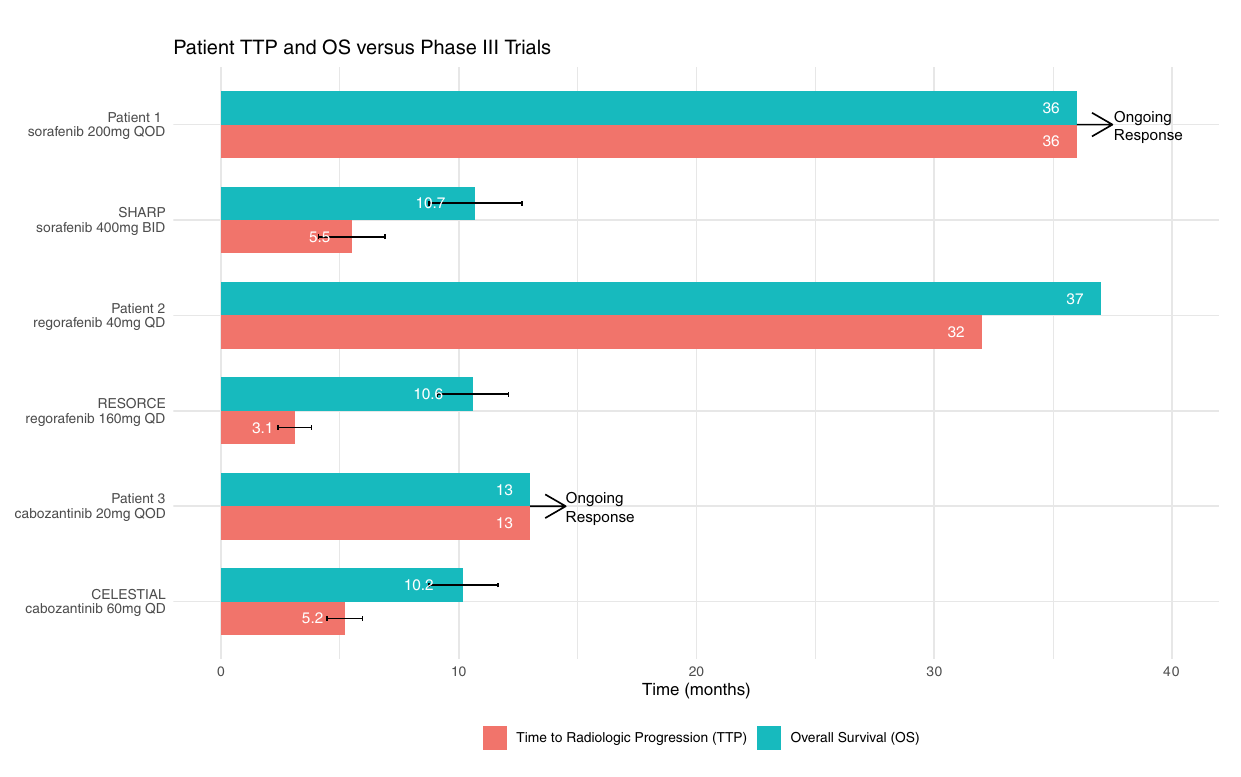
FIGURE 2 | The average Time to Radiologic Progression (TTP) and Overall Survival (OS) as reported in the SHARP, RESORCE and CELESTIAL trials are above. Patient 1 ’ s and Patient 2 ’ s corresponding TTP and OS on TKI therapy are both signi fi cantly longer than the trial averages despite being on much lower doses of therapy than the trial regiments. Patient 3 continues to have PFS beyond the CELESTIAL reported TTP on 1/6 th the clinical trial target